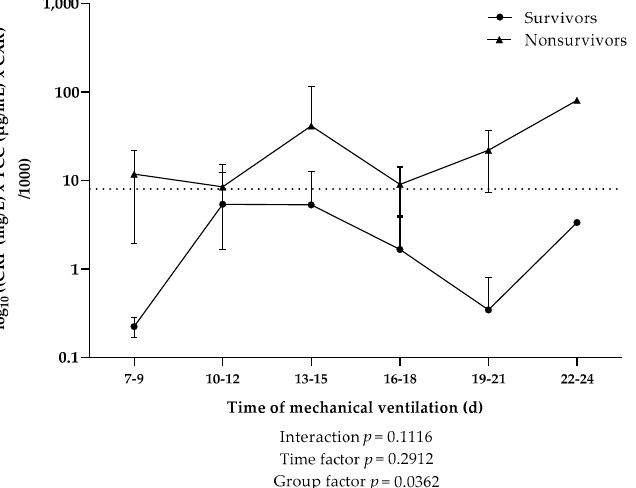
indicates the survival threshold. p -Values were calculated by linear mixed model of clustered log- log-transformed data. transformed data.